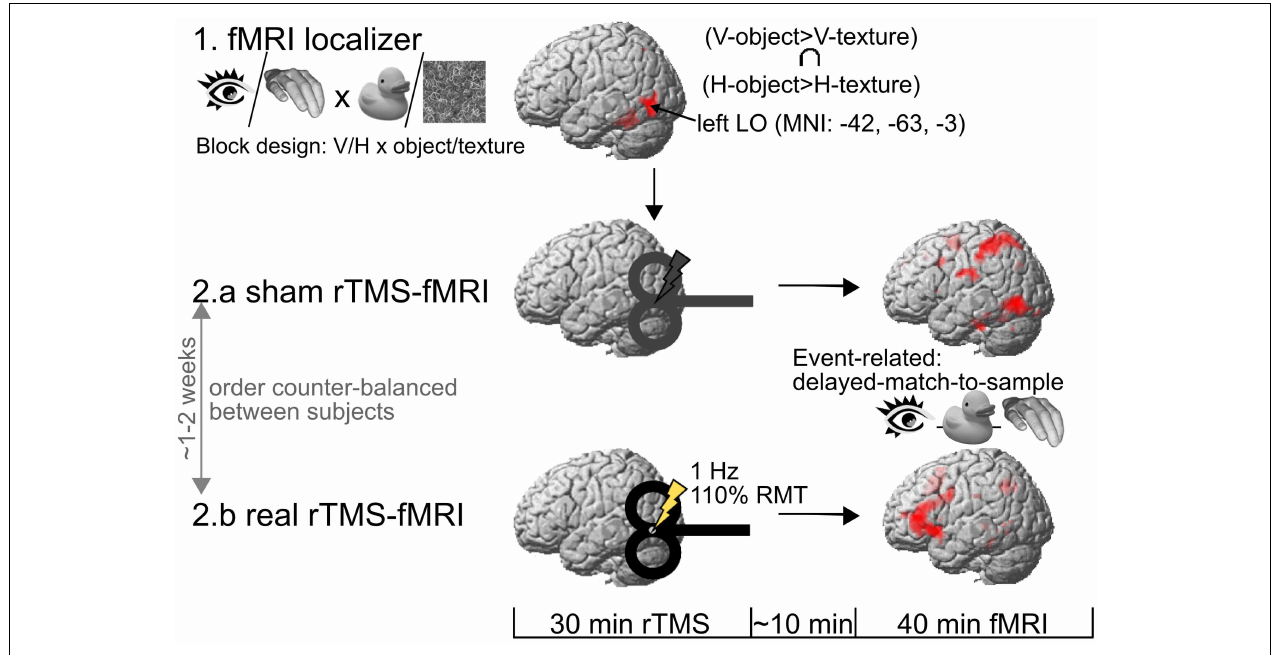
FIGURE 1 | Experimental procedure. One day after a behavioral training session (not illustrated here), subjects took part in an fMRI localizer in order to identify the rTMS target area in the left lateral occipital cortex (LO). The rTMS target area was defined by the convergence of visual (V) and haptic (H)